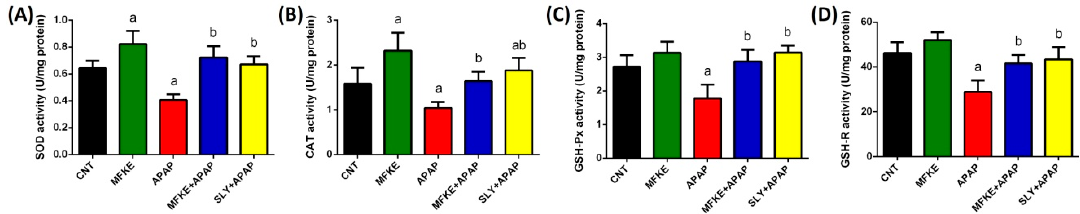
Figure 4. Effects of MFKE on the activity of antioxidant enzymes in rats treated with APAP-induced liver toxicity. Data are expressed as mean ± SD ( n = 7); a p < 0.05 vs. control rats; b p < 0.05 vs. APAP-treated rats using Tukey’s post hoc test. ( A ) Superoxide dismutase, ( B ) Catalase, ( C ) Glutathione peroxidase, and ( D ) Glutathione reductase.